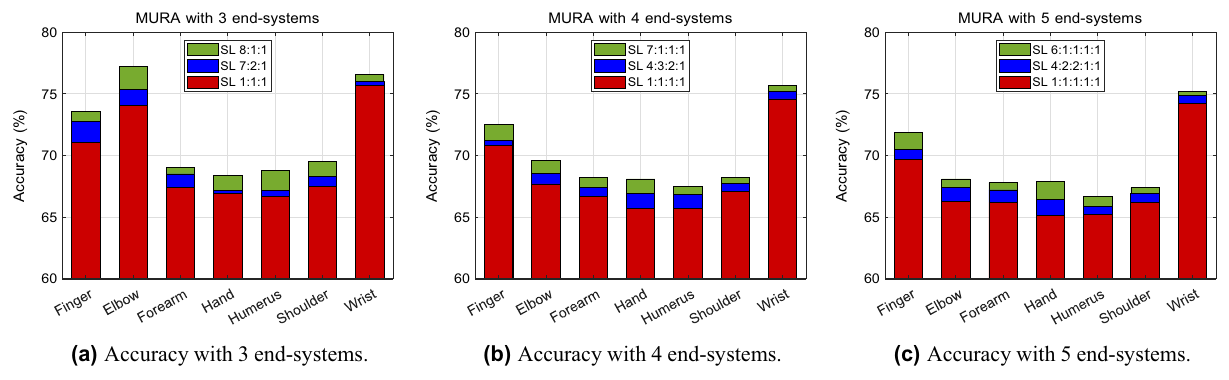
Figure 7. Accuracy of the seven body parts using MURA dataset for ( a ) 3, ( b ) 4, and ( c ) five